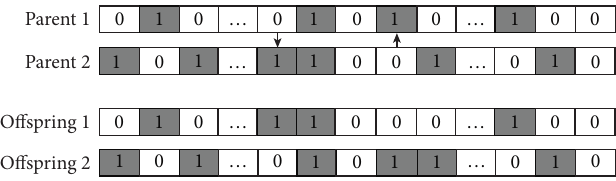
Figure 1: Two-point crossover operation.